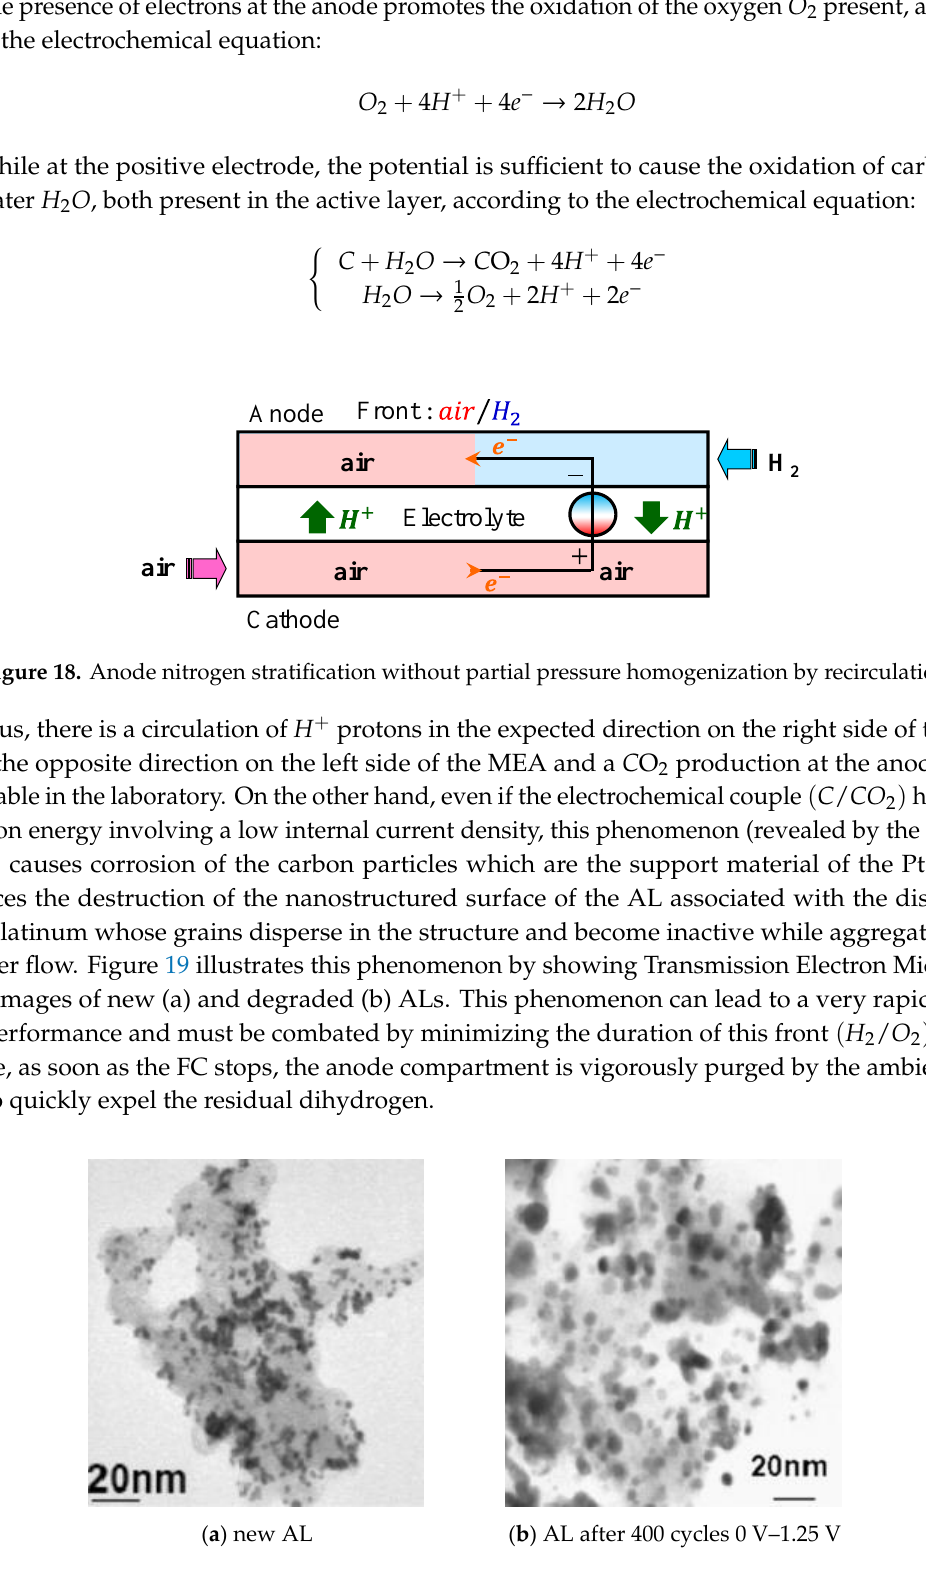
Figure 19. Platinum particles on carbon support (dark dots) before ( a ) and after ( b ) exposure to 400 potential changes between 0.0 V and 1.25 V [47]. 400 potential changes between 0.0 V and 1.25 V